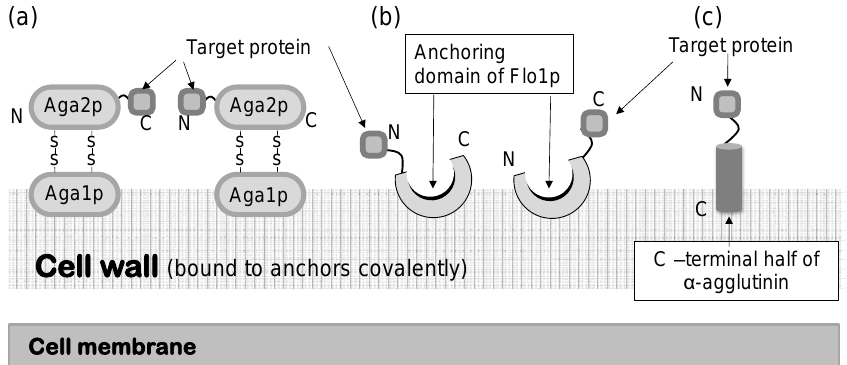
Cytosol (Fusion proteins are produced here and transported by exocytosis.) Figure 1. Molecular display systems in Saccharomyces cerevisiae . A target protein is immobilized by several types of anchoring proteins. ( a ) a-agglutinin-based display system. ( b ) Flo1p-based display system. ( c ) α -Agglutinin-based display system. Figures were adapted from [47].